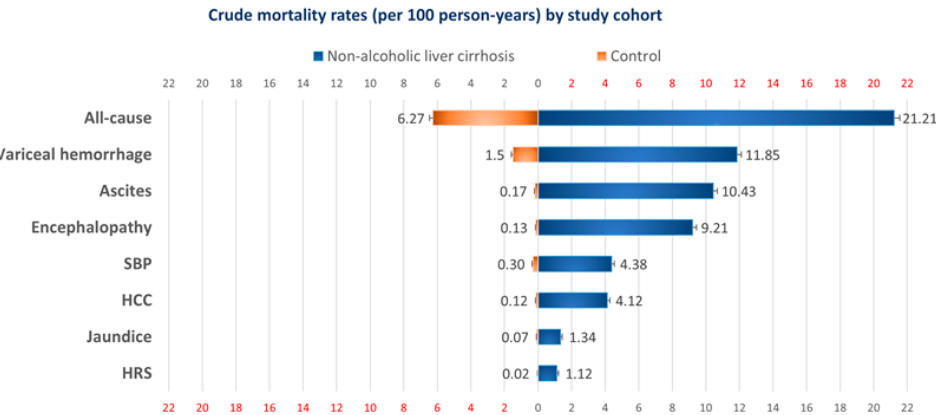
Figure 2. An illustration depicting the difference in excess mortality risks between non-alcoholic liver cirrhosis and control